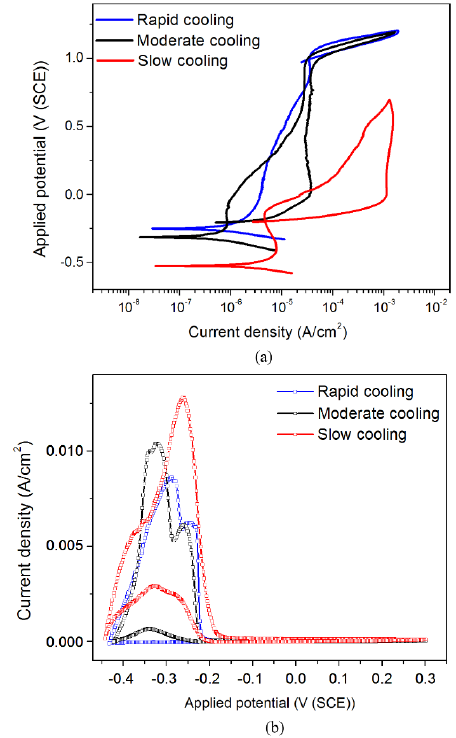
Figure 3. CPP (a) and DL-EPR (b) curves of 2205 DSS solution- treated and cooled under different conditions.